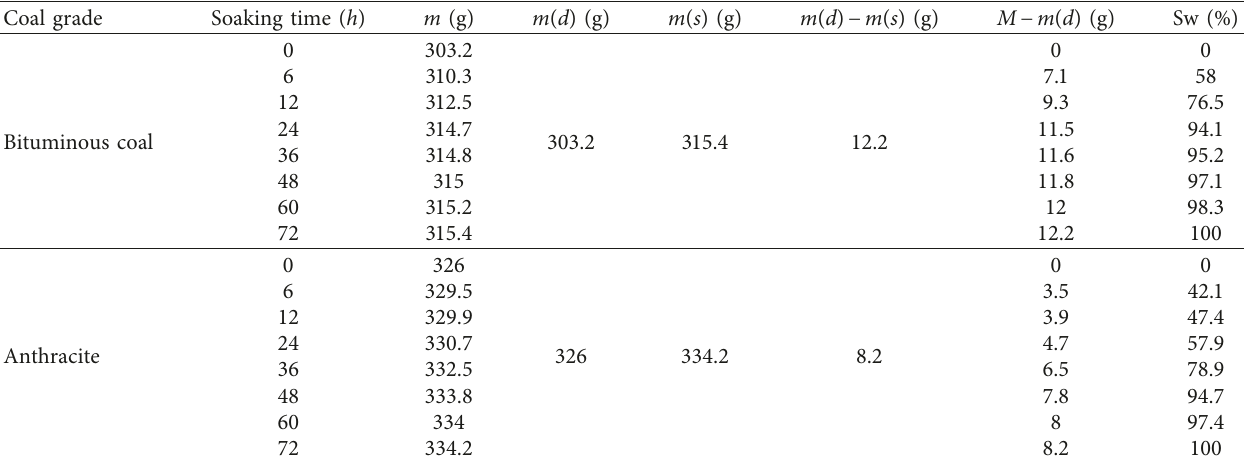
Table 1: Two coal samples water immersion weight and Sw.